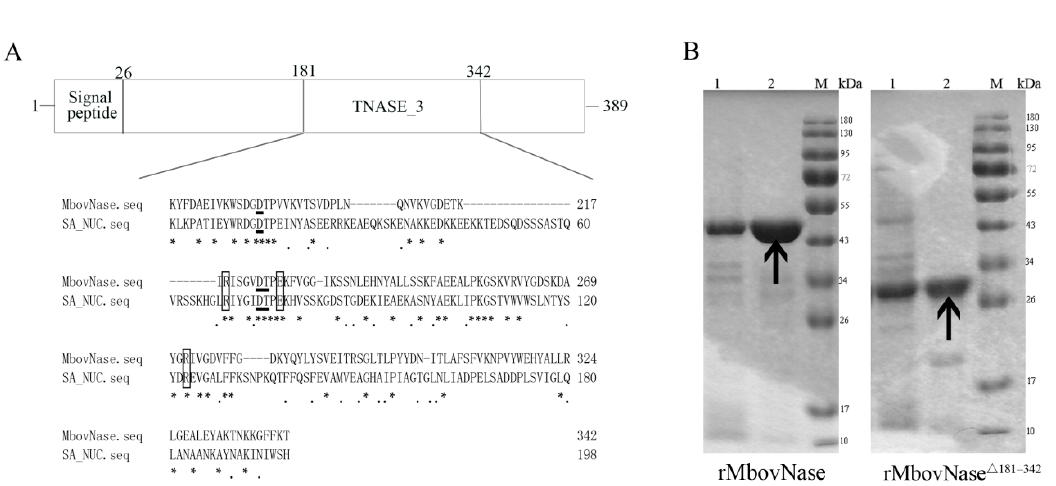
Figure 1. MbovNase organization, expression, and purification. ( A ) Schematic of MbovNase. The protein contains 389 amino acids with N terminal type 1 signal sequence (aa 1–26) inserting into the membrane. Alignment of amino acid sequences in Staphylococcus aureus thermonuclease enzymatic domain (SNc) shows that amino acids essential to nuclease activity arginine (R) residues at 219 and 272 and glutamic acid (E) at 227 (shown by the open boxes), and the aspartic acid (D) at aa 194, 224 and threonine (T) at aa 225 for the calcium binding motif (shown with the underline mark) are conserved sites [11]; Asterisks indicate positions conserved and dots represent positions similar; ( B ) Detection of expression of rMbovNase and its variant by 12% SDS-PAGE. The proteins were stained with coomassie brilliant blue R250 after SDS-PAGE. Left : His-tagged rMbovNase; Right : His-tagged rM.bovNase Δ 181–342 . Lane 1: Total-cell lysate of E. coli pET30a-MBOV_RS02825 ( left ) or E. coli pET30a-MBOV_RS02825 Δ 181–342 ( right ) induced by IPTG; Lane 2: Purified His-tagged rMbovNase ( left ) and rMbovNase Δ 181–342 ( right ). The arrows indicate rMbovNase and rMbovNase Δ 181–342 . M w (kDa) represents molecular weight of reference proteins.